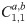
Disagreement between MCC and Kappa for C1,1a,b with a = 0.2, as function of b ≥ 0.The negative class is classified at random. If b > 1 the positive class is mainly misclassified, and the negative class is underrepresented. (a) A zoom of the detail for b ≤ 2. (b) For b ≤ 30.